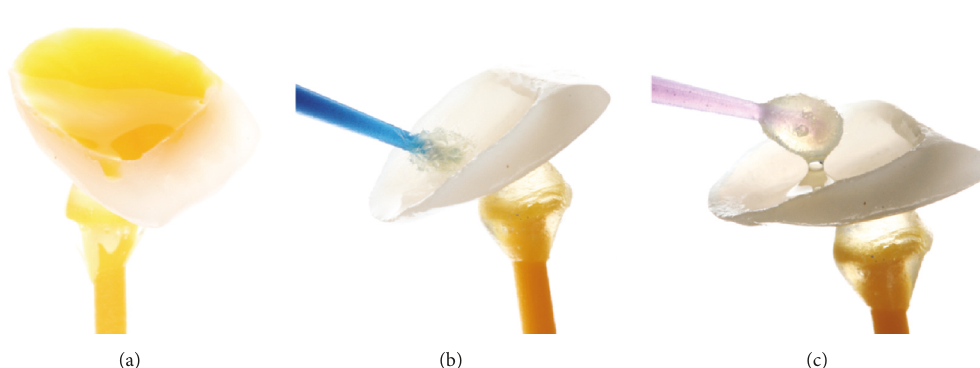
Figure 15: Ceramic treatment surface. (a) The conditioning of the veneer with 5% hydrofluoric acid for 20 seconds. (b) Silane application (Monobond Plus, Ivoclar Vivadent, Liechtenstein, Germany). (c) Application of bonding agent (Heliobond, Ivoclar Vivadent, Liechtenstein, Germany).